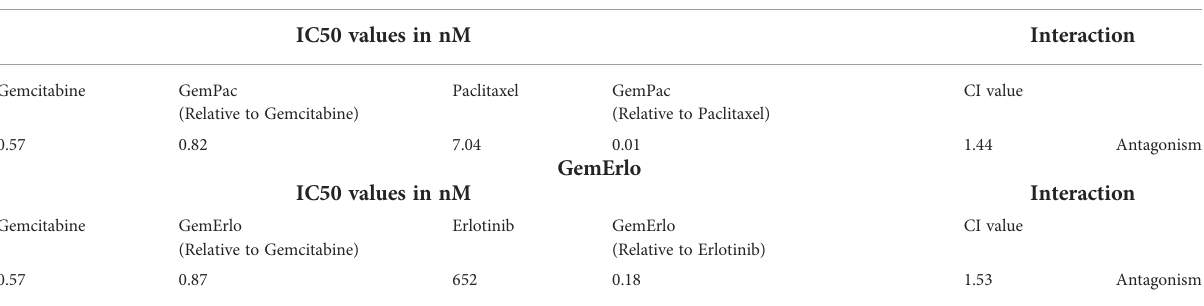
TABLE 4 Drug interaction of GemPac and